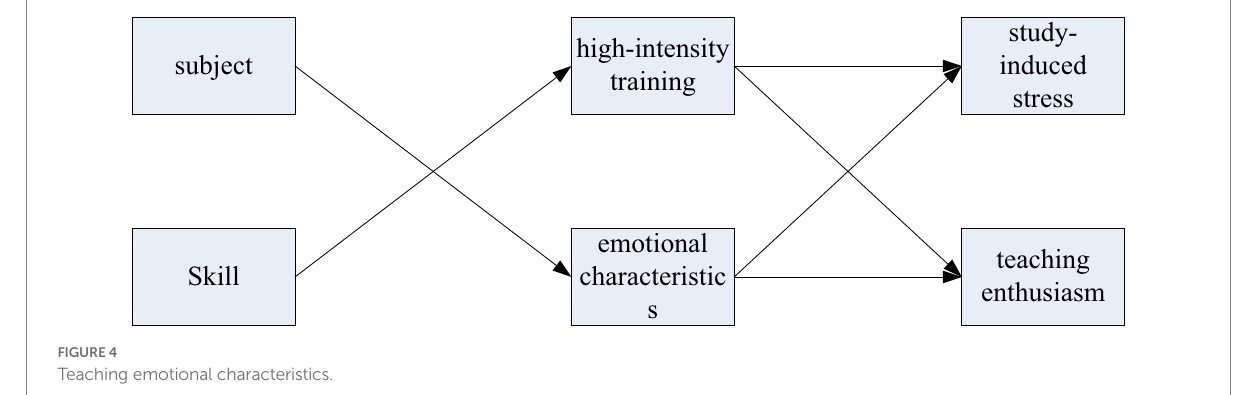
FIGURE 4 Teaching emotional